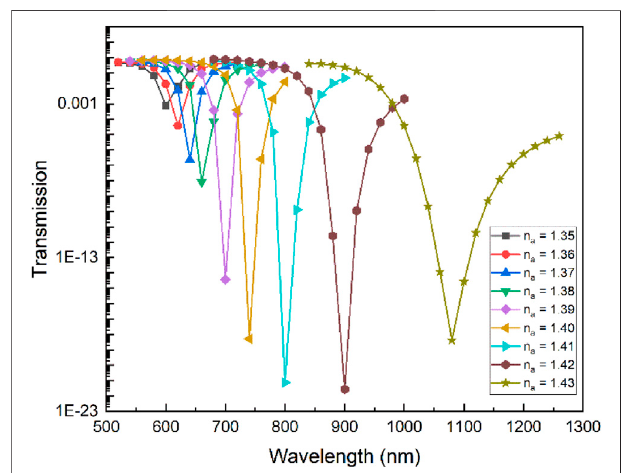
FIGURE 5 | Evolution of the con fi nement loss as a function of wavelength for analytes with different RIs for 5% GeO 2 doped silica core, d (cid:2) 5 nm, and t g (cid:2) 40